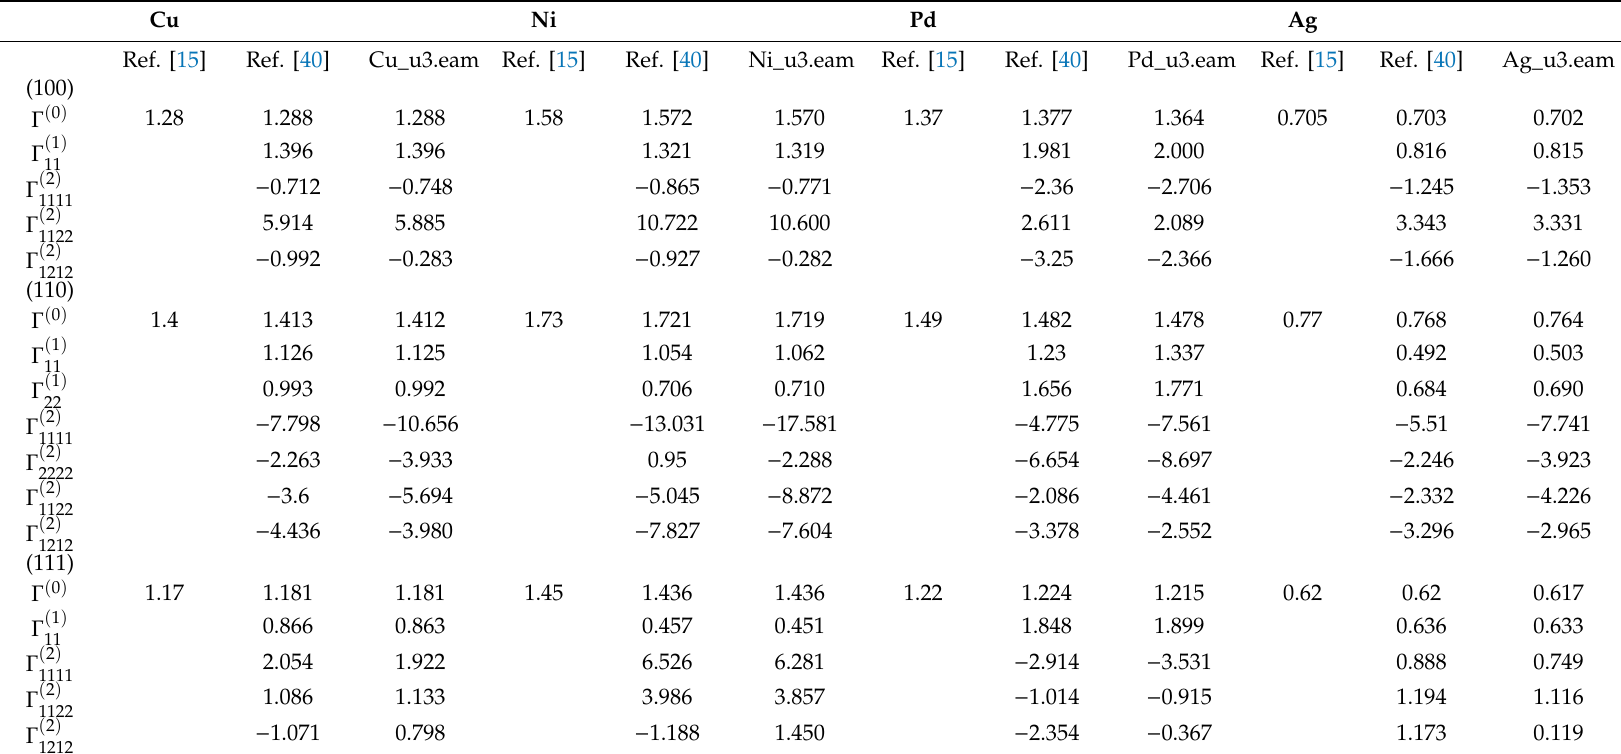
Table 3. Surface properties of face-centered-cubic (FCC) crystals (unit: J / m 2